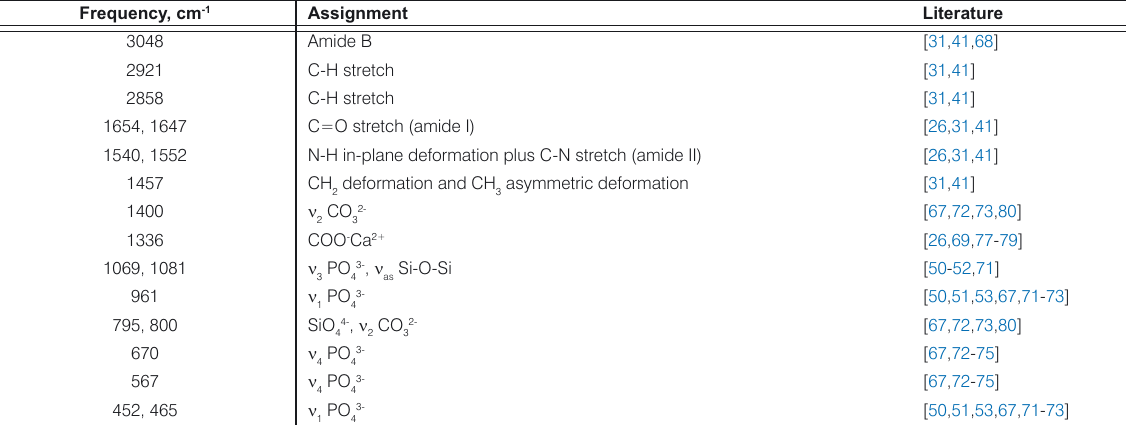
HA on the synthesized C-CPS/W hybrids after immersion in 1.5 SBF 3